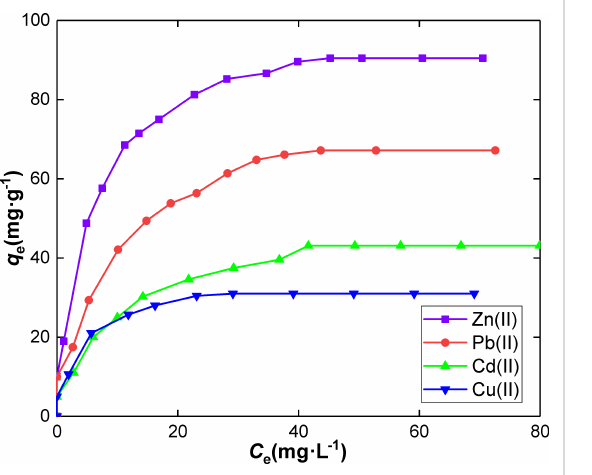
Figure 8: Effect of concentration on metal ion adsorption onto SiNL. Adsorption dose: 10 mg, V = 10 mL, at 25 °C and pH 6 for Zn(II), Pb(II), Cd(II) and Cu(II) ions, ∆ q e = 0.3 (mg·g − 1 ).